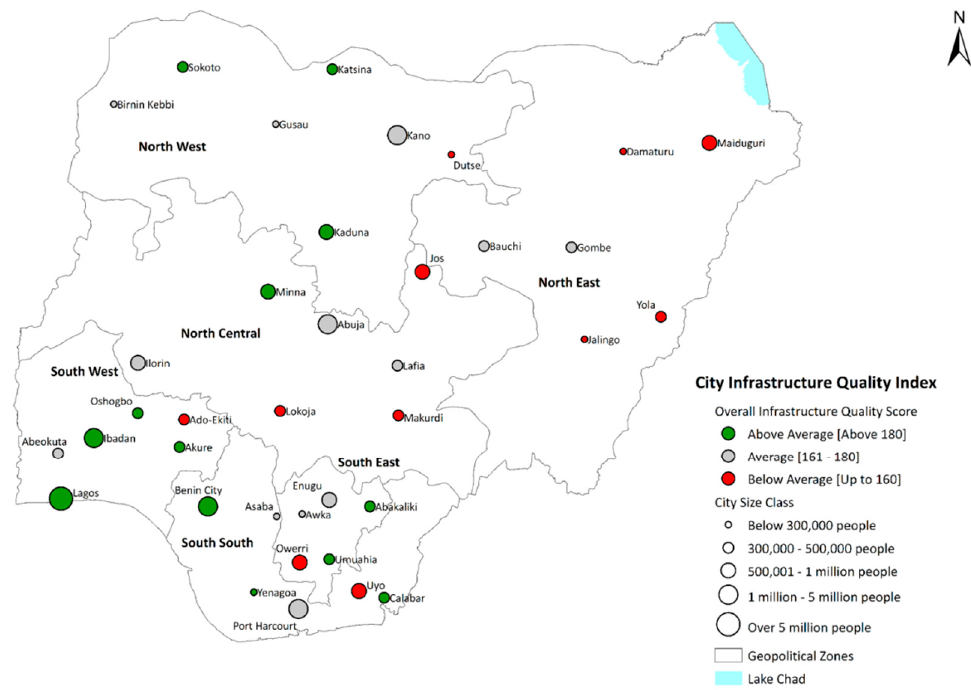
Figure 4. The City Infrastructure Quality Index 2007/2009.